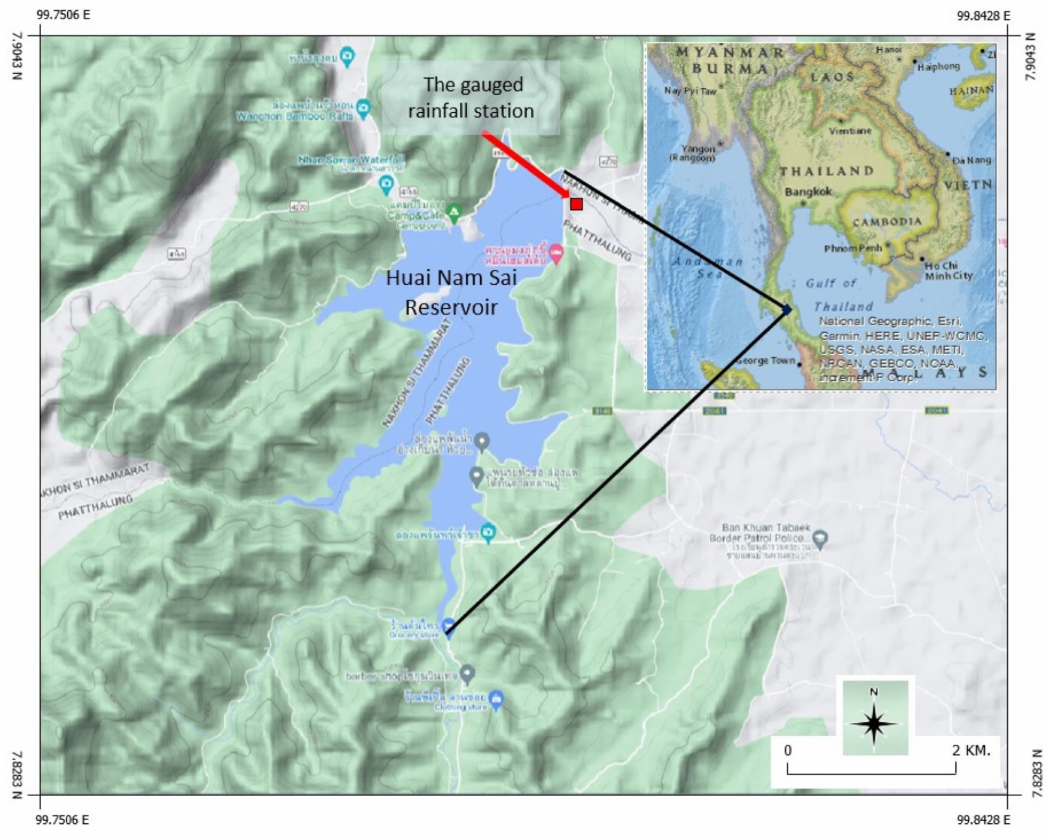
Figure 2. A location of Huai Nam Sai